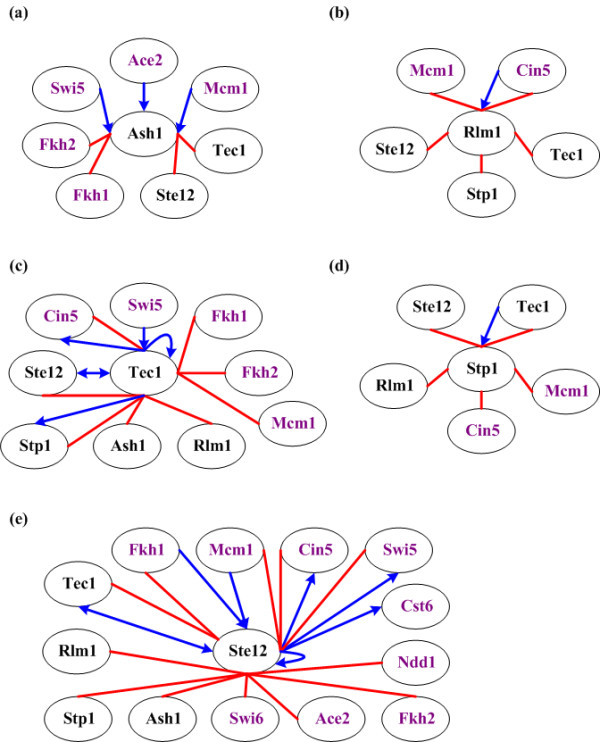
Interactions between a novel cell cycle TF and the other identified cell cycle TFs. The physical or genetic interactions between a novel cell cycle TF ((a) Ash1, (b) Rlm1, (c) Tec1, (d) Stp1, and (e) Ste12) and the other identified cell cycle TFs are shown. Each oval indicates an identified cell cycle TF. A TF name is colored purple if it is a known cell cycle TF but black otherwise. Two ovals are connected by an undirected red line if these two TFs have physical interactions indicated by the current protein-protein interaction data [48]. Two ovals are connected by a directed blue line if the two TFs have genetic interactions indicated by ChIP-chip or/and mutant data [10]. For example, Ace2→Ash1 means that either TF Ace2 binds to the promoter of gene ASH1 or the disruption of TF Ace2 results in a significant change of the expression of gene ASH1.